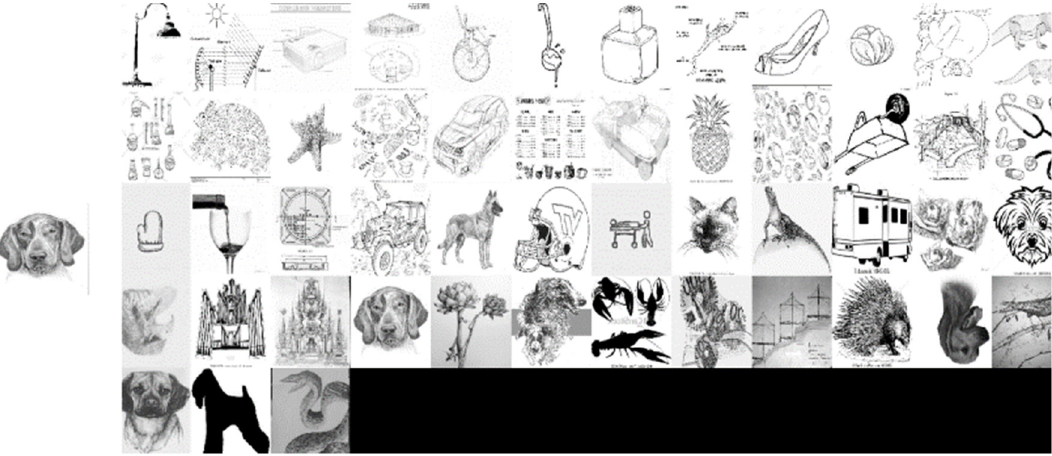
Figure 25. Query-retrieved image samples from the 1st set based on InfoGAN retrieval system [42].